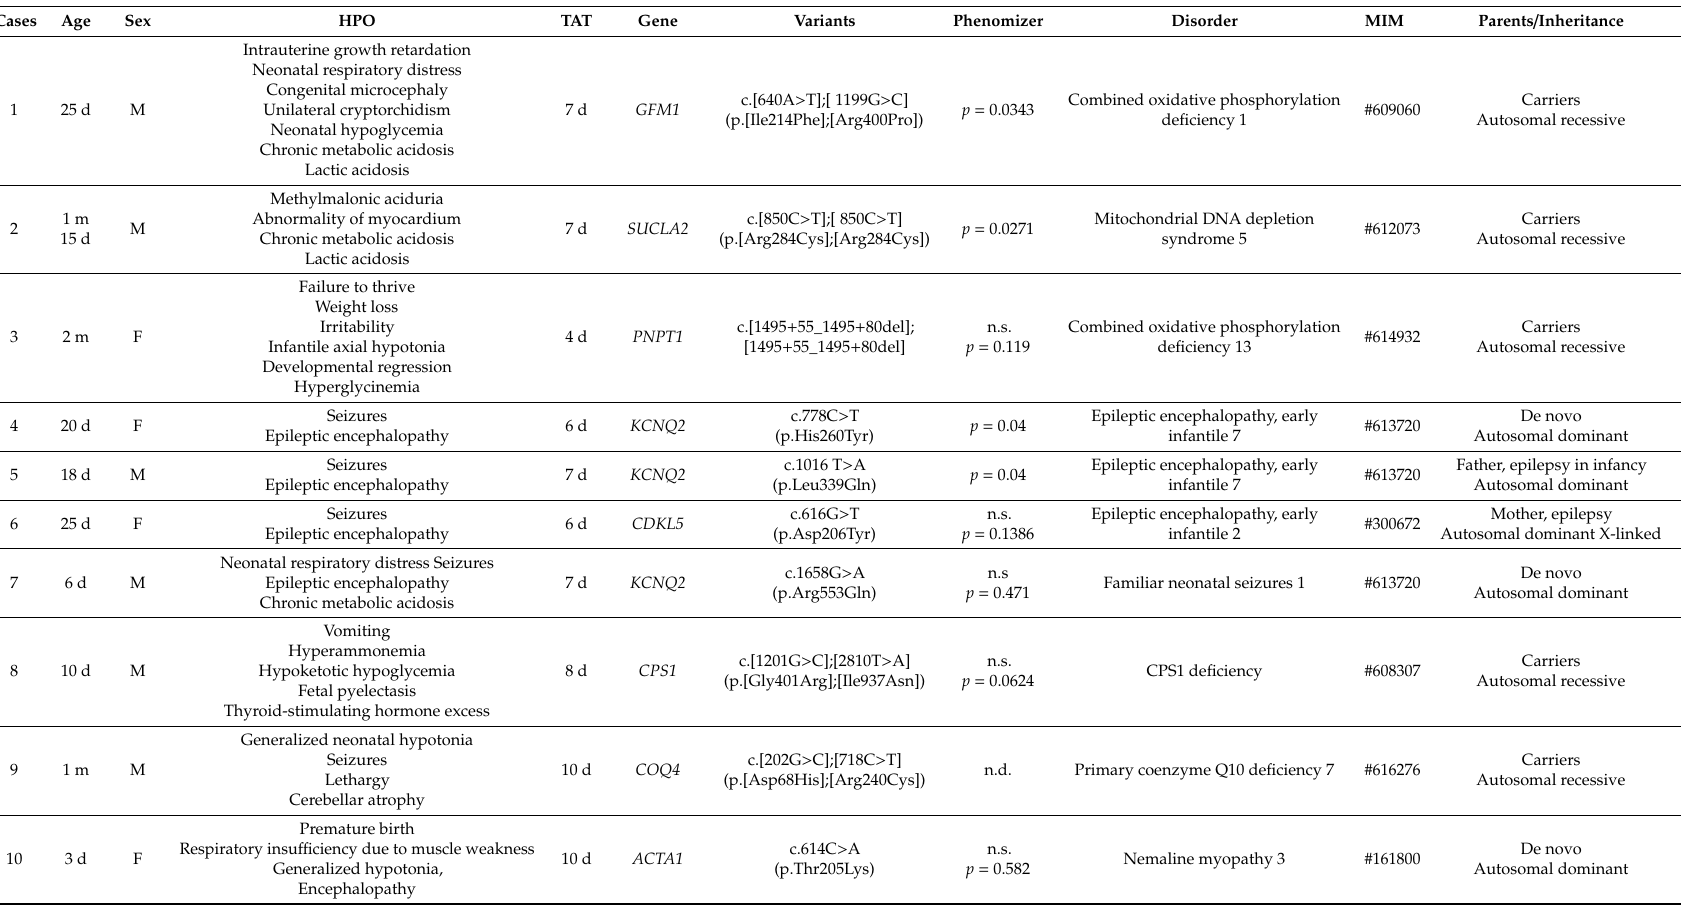
Table 1. Demographic and clinical data and genetic findings in patients with definitive / probable causative